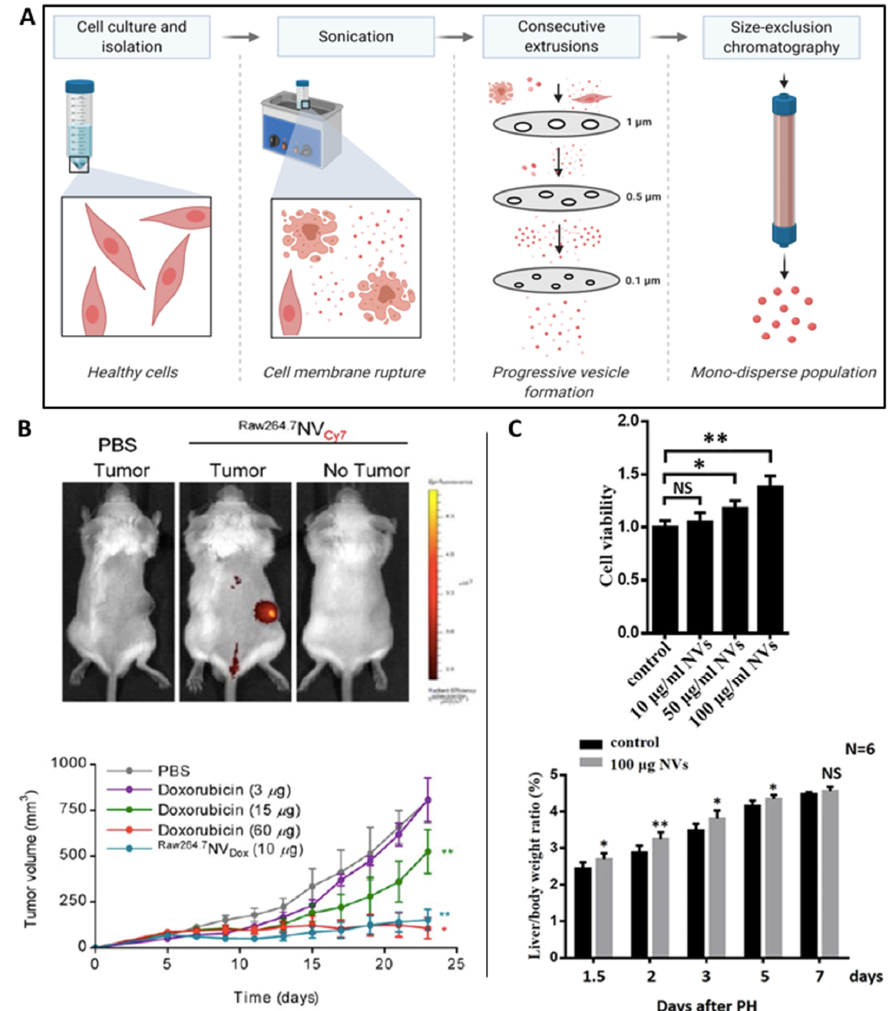
Figure 4. The use of cell-derived nanovesicles (CDNs) as an EV-mimetic system. ( A ) Schematic illustration of the process to fabricate CDNs from whole cells. ( B ) Macrophage-derived CDNs loaded with doxorubicin traffic to tumour tissue (upper panel) and reduced tumour growth compared to free-doxorubicin (lower panel). Reproduced from [102], with permission from American Chemical Society, 2013. *, p < 0.05; **, p < 0.01 compared to PBS. ( C ) CDN-derived from hepatocytes stimulated proliferation in vitro (upper panel) and liver regeneration in vivo (lower panel). Reproduced from [106], under the creative commons licence, 2018. NS, not significant; *, p < 0.05; **, p <